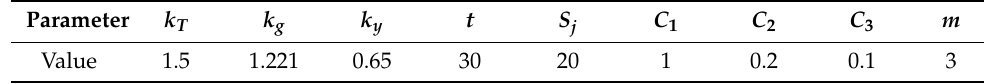
Table 2. Information of cutting